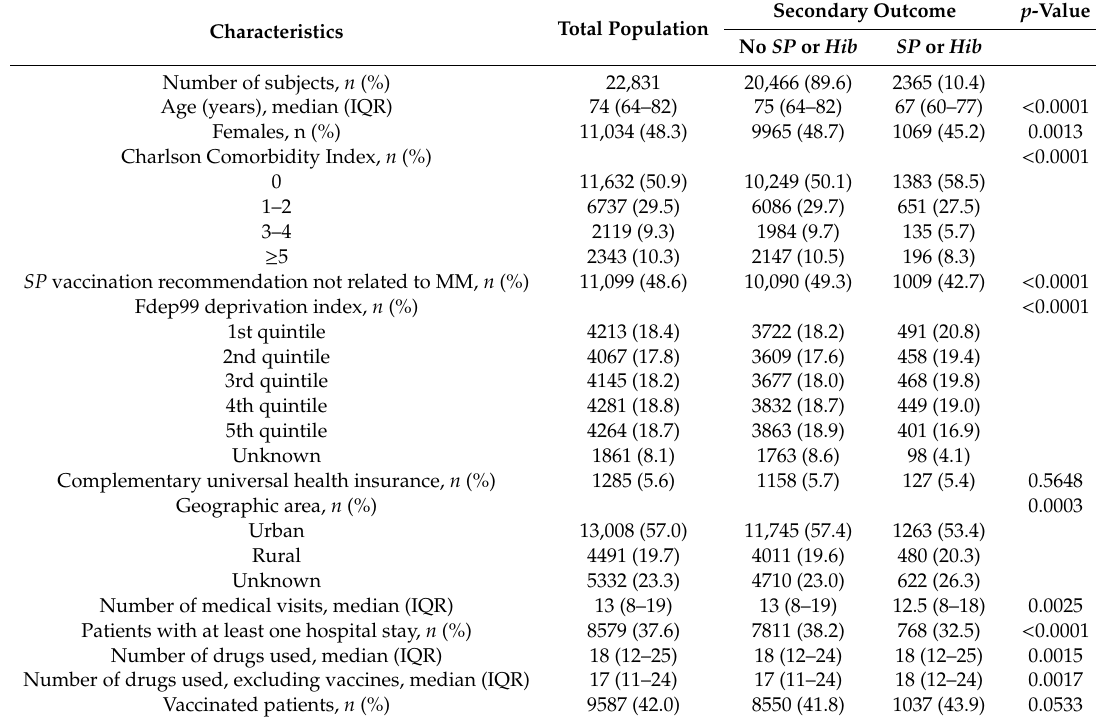
Table 2. Sociodemographic and medical characteristics of patients during the observation period (12 months before MM diagnosis)—secondary outcome.